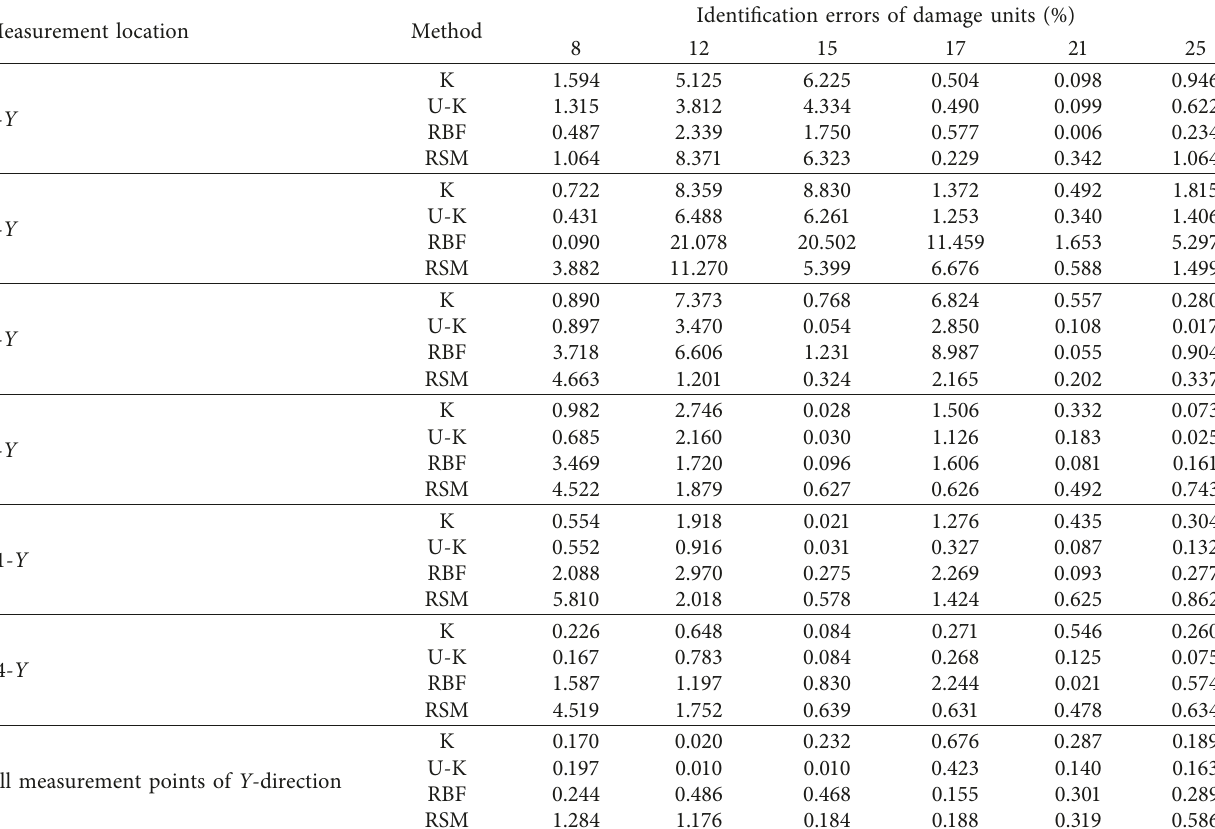
Figure 9: FRFs before and after being updated. (a) Real part. (b) Imaginary part. Table 4: Identification error of elasticity modulus of each damage